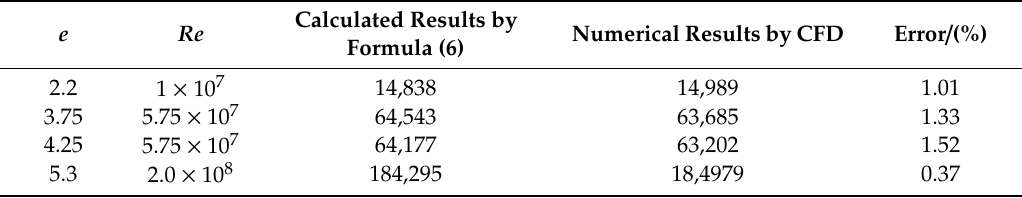
Table 4. Validation of Formula